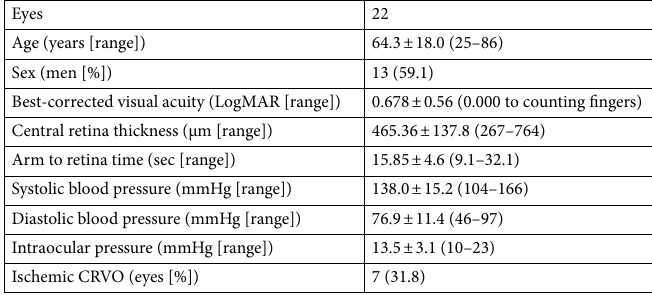
Table 1. Baseline characteristics. Data are represented as the mean ± SD.